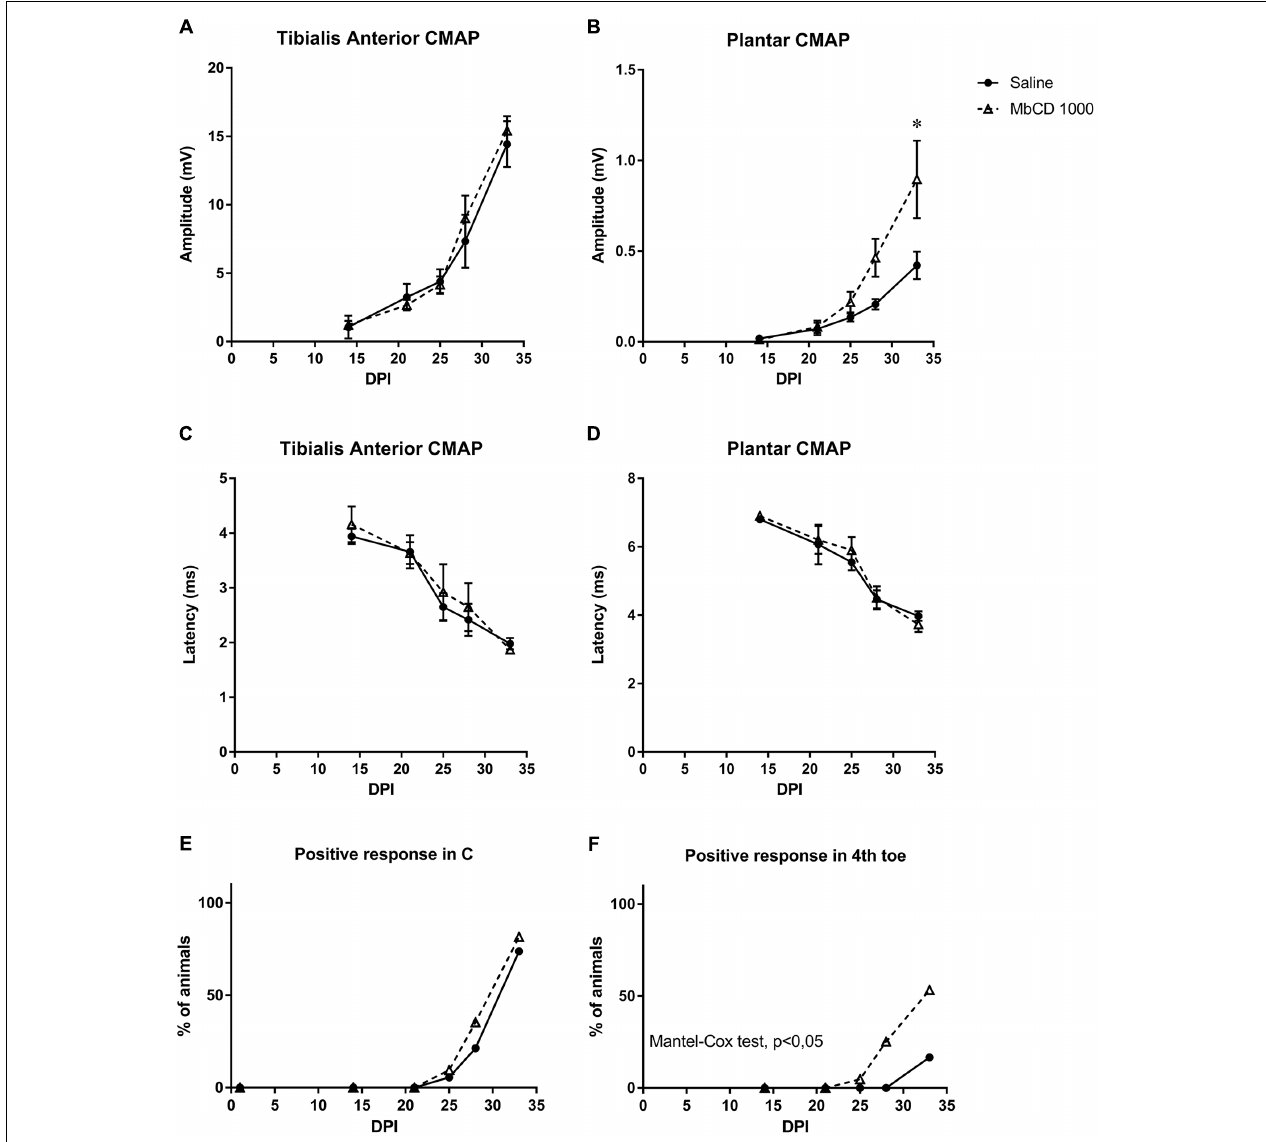
FIGURE 9 | M β CD treatment accelerates motor and sensory functional recovery following sciatic nerve injury. (A–D) Electrophysiological results after nerve injury in mice treated with vehicle or with M β CD. Results of CMAP amplitude (A,B) and latency (C,D) recorded in TA and PL at 14, 21, 25, 28, and 33 dpi. Data are shown as the mean and SEM (bars). ∗ p < 0.05 with two-way Anova and Bonferroni test. (E,F) Pinprick test results to analyze sensory reinnervation in the hindpaw pad C (E) and 4th toe (F) . Results show the percentage of animals with positive response in each area in the groups treated with vehicle or M β CD. p < 0.05 Mantel–Cox test indicate differences in the proportion of mice with